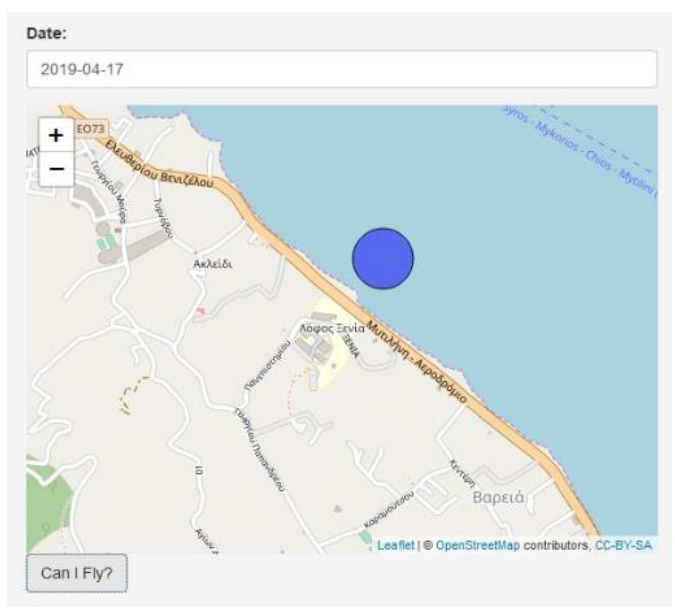
Figure 2. The Leaflet JS Map element and the date-picker element of the application Graphical User Interface (GUI).